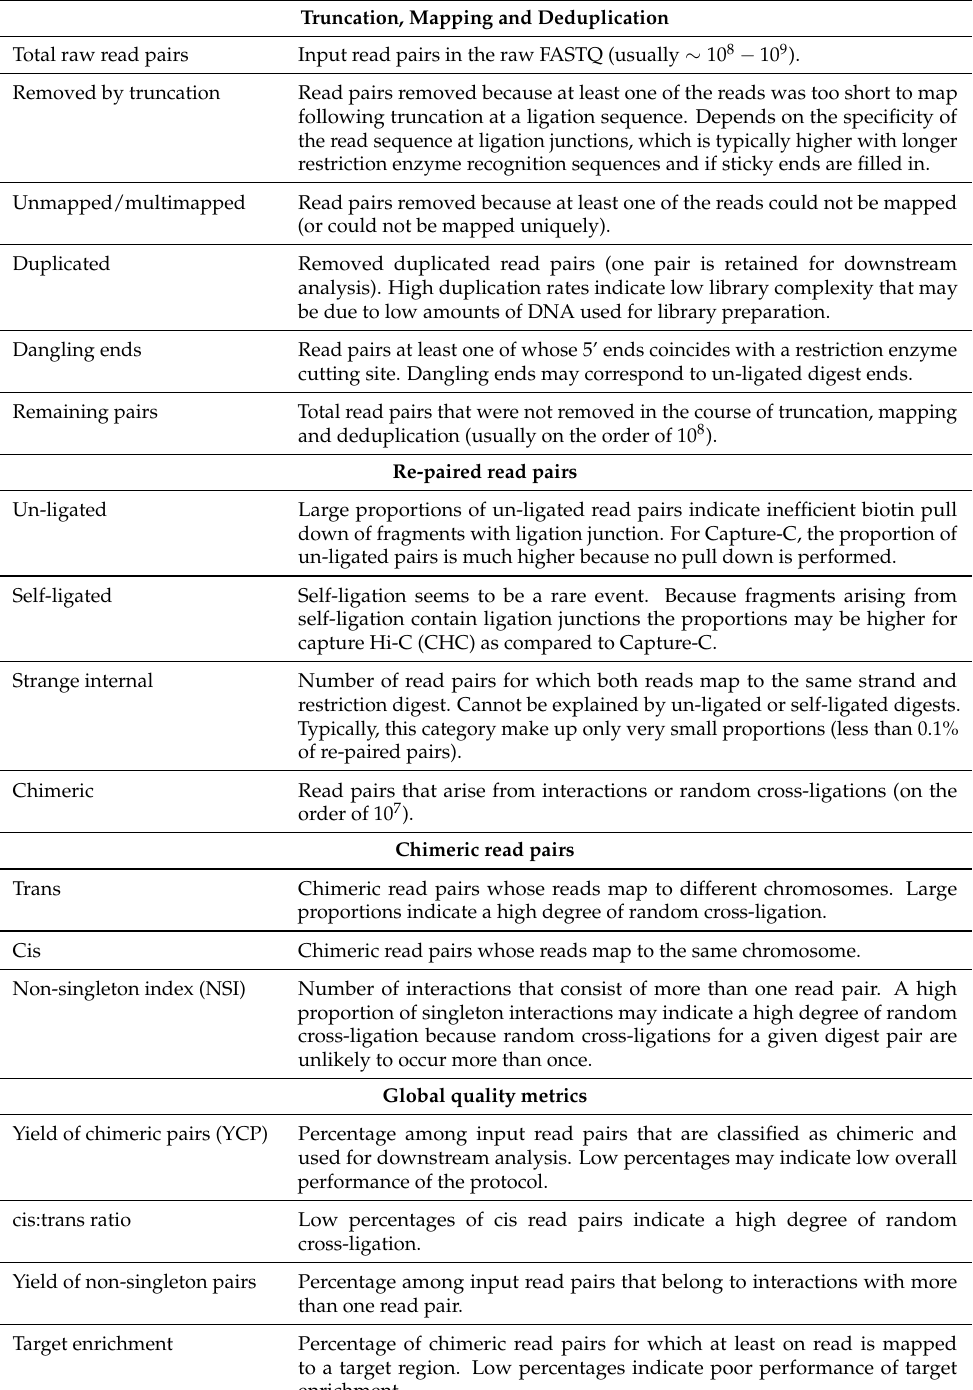
Table 1. Quality metrics that can be used to assess the quality of an experimental dataset. It is not possible to provide precise cutoffs for the quality metrics but instead we recommend that researchers use the metrics to compare experiments in a given study to identify potential outliers that may require